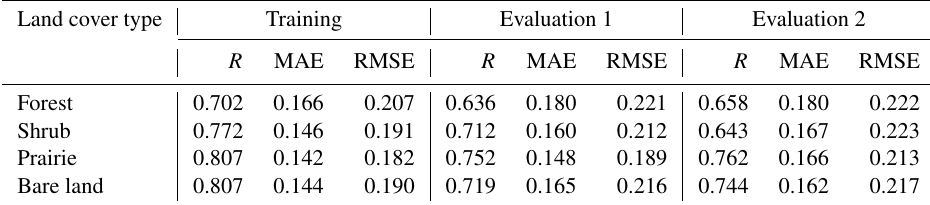
Table 6. The performance of random forest models on training and evaluation data for four land cover types. Evaluation 1 is used to evaluate the estimation performance of the established retrieval models on fractional snow cover in January and February (Fig. 7). Evaluation 2 is used to analyze the prediction performance of the retrieval models in December (Fig.